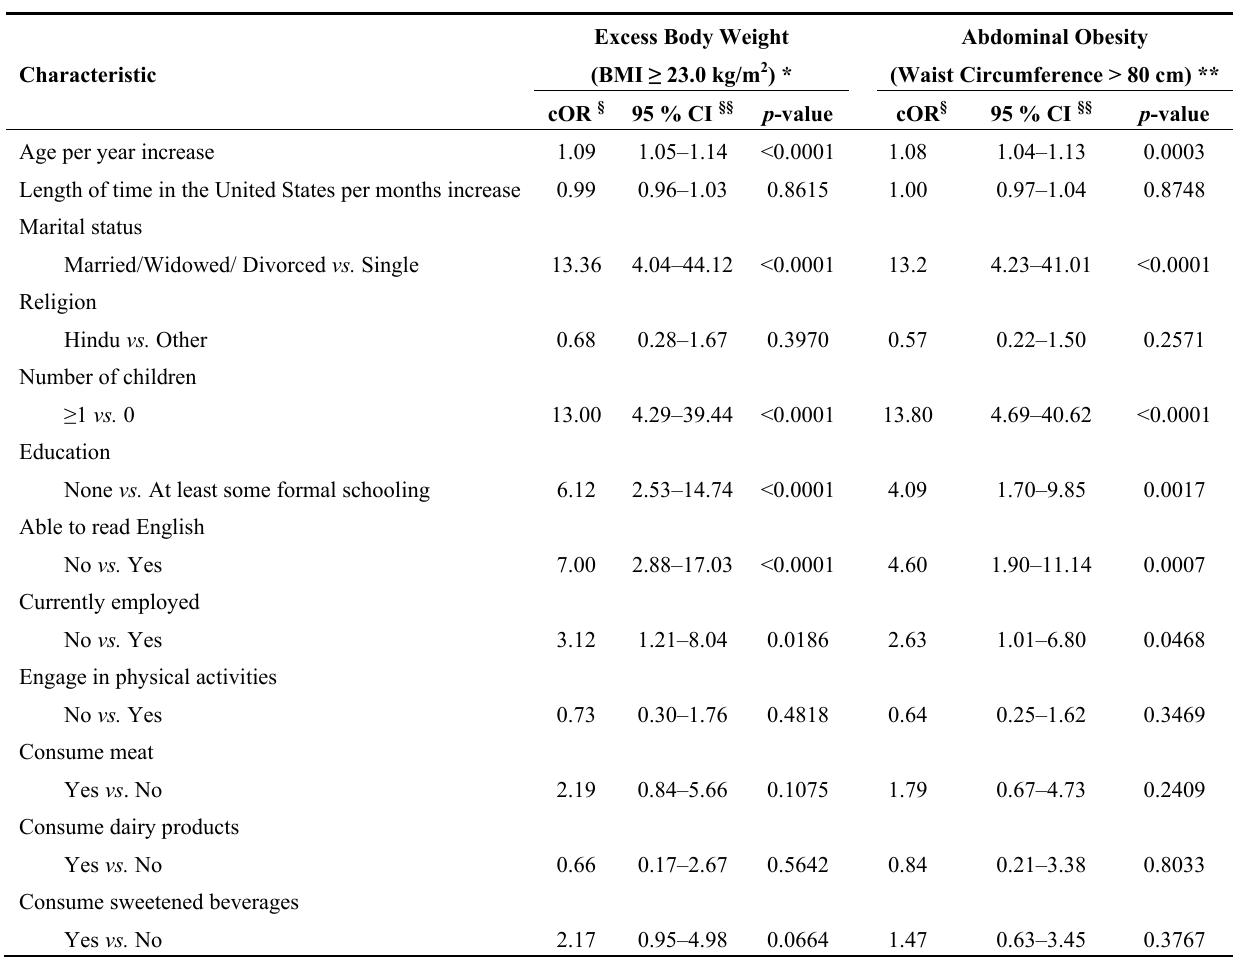
Table 2. Univariable logistic regression analyses of factors associated with excess